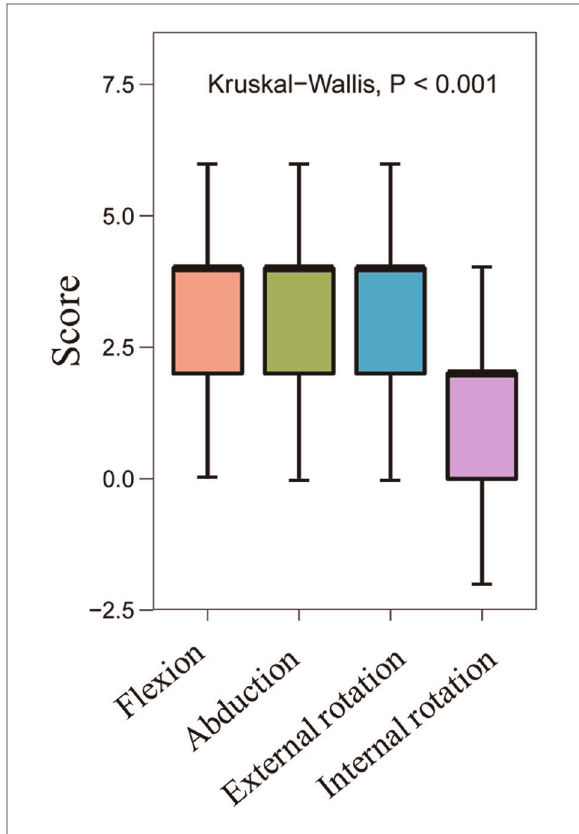
FIGURE 4 Box chart showing the degree of improvement in the scores of four indices involving the active range of motion.